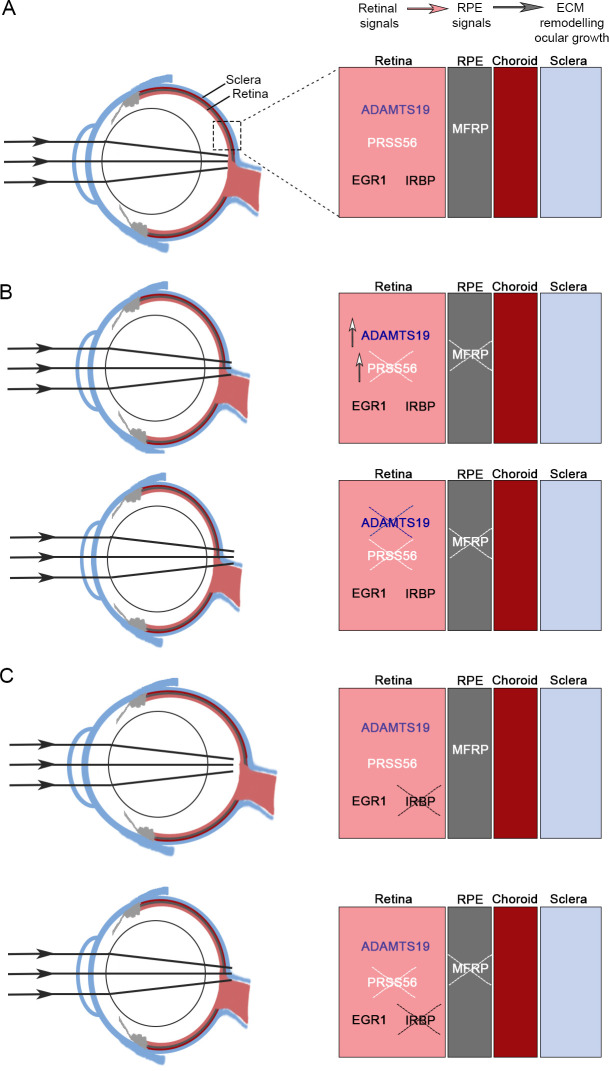
Summary of the molecular network involved in normal and excessive ocular axial growth.(A-C) Schematic representations of emmetropic (A), hyperopic (B), and myopic (C) mouse eyes and a summary of corresponding molecular correlates associated with ocular growth described in this study. It is generally accepted that ocular growth relies on a cascade of signaling events originating from the retina that are sequentially transmitted to the sclera to promote scleral ECM remodeling and ocular elongation. During postnatal developmental stages in humans and the post eye-opening period in the mouse, ocular growth is guided by visual cues to ensure that the optical power of the eye matches its axial length, a state referred to as emmetropia (A). Genetic inactivation of Prss56 or Mfrp leads to a significant reduction in ocular axial length causing the focused image to fall beyond the retina (hyperopia) (B). Retinal Adamts19 mRNA was significantly upregulated in response to impaired ocular growth caused by mutations in Prss56 or Mfrp. Although ADAMTS19 is not required for ocular growth during normal development, its inactivation exacerbates ocular axial length reduction in Prss56 and Mfrp mutant mice. Additionally, inactivation of Prss56 or Mfrp prevented excessive ocular elongation in a mouse model of early-onset myopia caused by a null mutation in Irbp. Notably, Prss56 and Mfrp were found to be epistatic to Irbp during ocular elongation as shown by the ocular size of Irbp;Prss56 and Irbp;Mfrp double mutant mice being comparable to that of Prss56 and Mfrp single mutants (C). Overall, findings from this study show that PRSS56 and MFRP promote ocular growth during both normal and pathophysiological developmental processes.